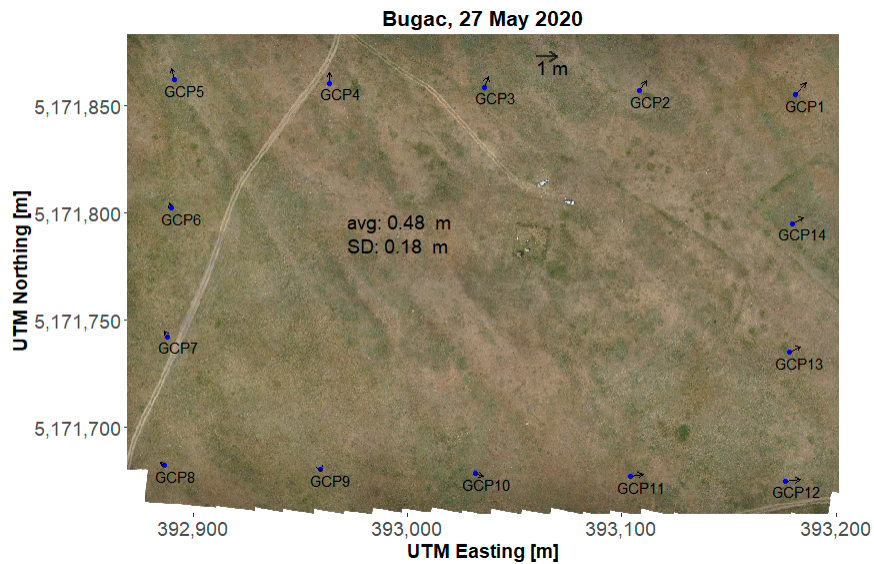
Figure 4. RGB orthomosaic from the Bugac (grassland) site taken on 27 May 2020. The GCPs on the RGB are highlighted with blue dots. The arrows point to the position where they should be according to their measured (STONEX S8) coordinates. The length of the arrays is multiplied by 10 for illustrative purposes, i.e., the 1 m arrow at the top of the image means 10 m at the orthomosaic.